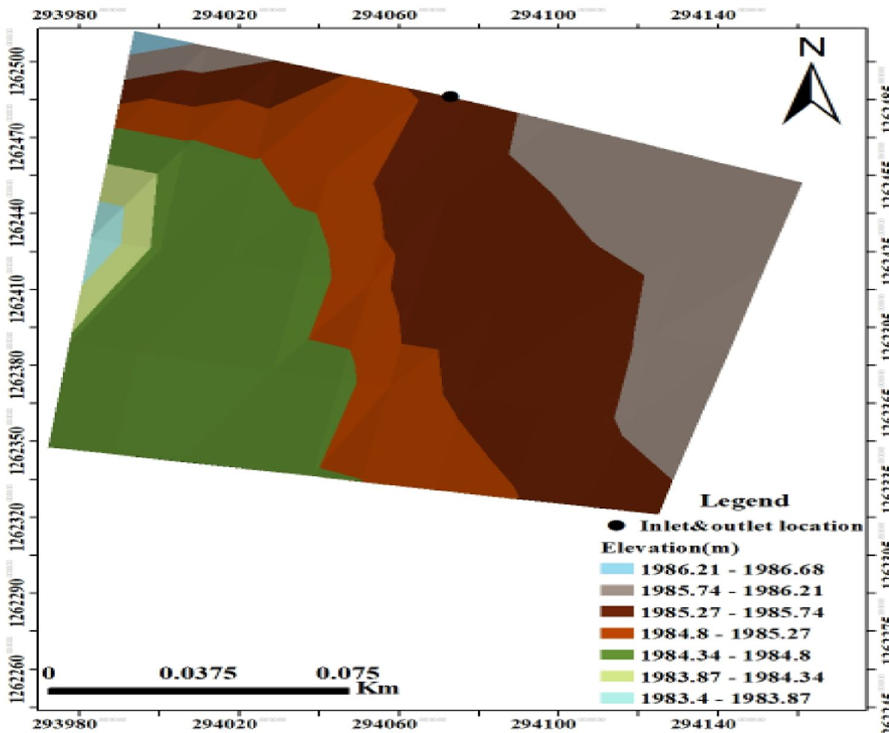
Fig. 9 Adebra NSR TIN map derived from design or original